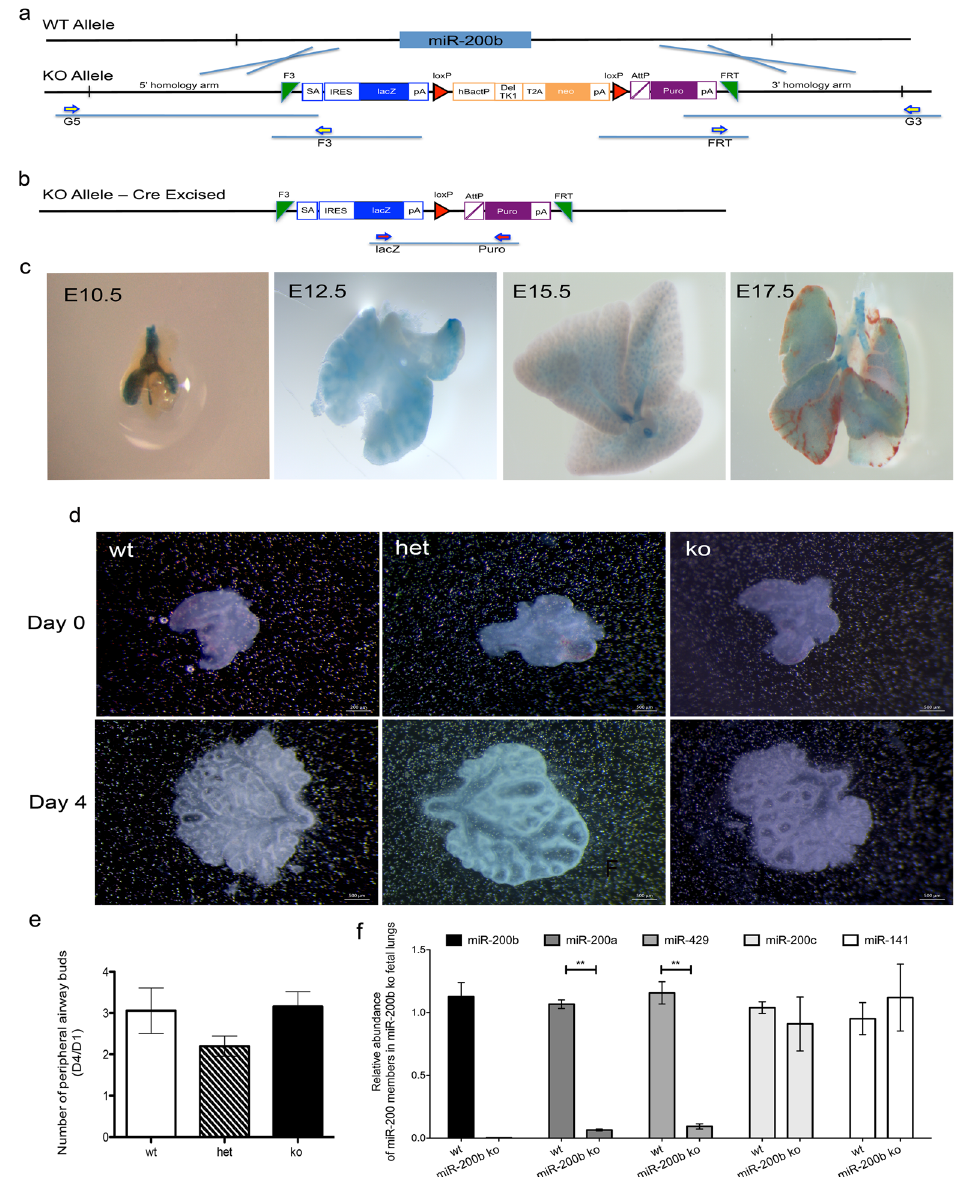
Figure 1. Generation and validation of miR-200b − / − mice (miR200b tm1.1(NCOM)MFGC ). ( a ) Targeted miR-200b knockout allele. The complete miR-200b non-coding gene (WT allele) was replaced by a NorCOMM cassette via targeted homologous recombination in C57Bl/6N mouse C2 ES cells. The NorCOMM targeting cassette consists of three functional components: a lacZ expression reporter (blue boxes); a loxP flanked (red triangles) h β act promoter driven ∆ TK1-T2A-neomycin selectable marker (orange boxes), which can be subsequently excised by cre-recombinase; and a docking cassette AttP-Puro-pA that can be utilized to exchange the entire NorCOMM cassette to any other allele (purple boxes) and once placed, the remaining flanked sequences can be removed by flpO-recombinase between F3 and FRT sites (green triangles) in vivo . The length of 5 ′ and 3 ′ homology arms are 2891 bp and 6595 bp in the targeting vector, respectively. The targeted miR-200b gene was highlighted in the resulting knockout allele (KO Allele). ( b ) Targeted miR-200b knockout mice. Removal of the h β act promoter driven ∆ TK1-T2A-neomycin cassette was performed by mating male miR200b tm1(NCOM)MFGC mice harboring the miR-200b KO allele with female CMV-Cre transgenic mice. Precise cre-excision of the neomycin cassette was determined by PCR and sequence validation, as shown with primers specific to LacZ and Puro cassette by purple arrows in Panel C. The resultant miR-200b cre-excised allele is shown as miR200b tm1(NCOM)MFGC . ( c ) LacZ staining of miR-200b − / − mice demonstrated the expression in both epithelial and mesenchymal cells during lung development. ( d,e ) Lung explants culture of E11.5 lung explants did not show significant differences in proximal branching morphogenesis between miR-200b + / + , miR-200b + / − and miR-200b − / − lungs. ( f ) RT-qPCR for all miR-200 family members on fetal lung explants using LNA primers. miR-200b absence was confirmed. miR- 200a and miR-429 were significantly downregulated, but no changes were observed in abundance of miR-200c and miR-141 ** P < 0.01, Student’s t-test, Data represent mean ± SEM of at least four independent